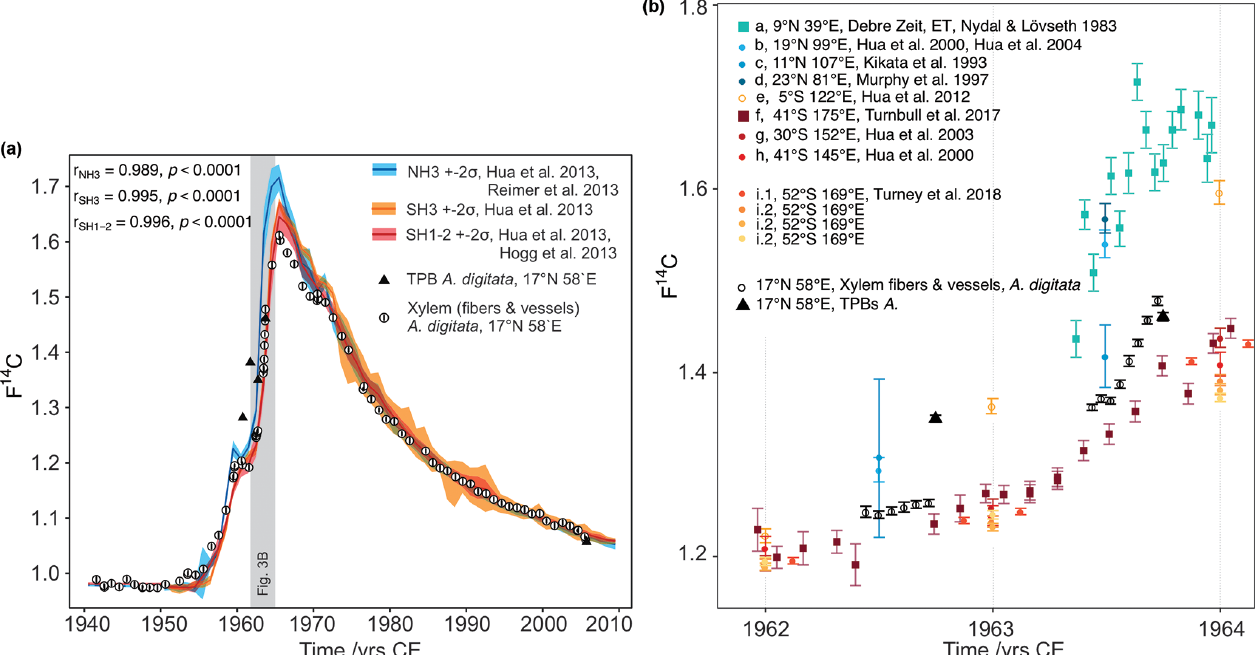
Figure 3. (a) Comparison of baobab F 14 C values with F 14 C curves for both hemispheres. Data prior to 1950 were taken from IntCal13 and SHCal13 (Reimer et al., 2013, Hogg et al., 2013). Data for 1950–2010 originate from Hua et al. (2013) (line: mean value, shade: ± 2 standard deviations ( σ )). The southern hemispheric increase in atmospheric F 14 C lags behind the Northern Hemisphere by about 1 year, and its peak is considerably shallower. The overall conformity of the baobab measurements (white dots with 2 σ error bar) with the course of the calibration curves proves the annual character of the growth zones. The values for baobab tree-ring cellulose (xylem fibers and vessels) lie between the values for both hemispheres for the steep increase in F 14 C and then apparently follow the course of SH 1 − 2 , although temporary shifted due to different vegetation periods. Four out of five terminal parenchyma bands (TPB, black triangles; error bars are smaller than the symbol size) show either much higher F 14 C values (1960–1962) or a lower value (2005) than the corresponding tree ring. (b) Baobab measurements in comparison to atmospheric (squares) and tree-ring data (circles) for NH 3 (a–d), SH 3 (e), and SH 1 − 2 (f–i) between 1962 and 1964. These years show strongly increasing atmospheric F 14 C values and were chosen to investigate the intra-annual baobab F 14 C values. For this period, the baobab F 14 C values lie between the higher NH 3 / SH 3 and the lower SH 1 − 2 values. A dip within the first half of the tree ring is followed by a slight (1962) or steep (1963) increase of the values. Note the inter- and intra-species’ variability from the same site (i.1 and i.2, Turney et al.,